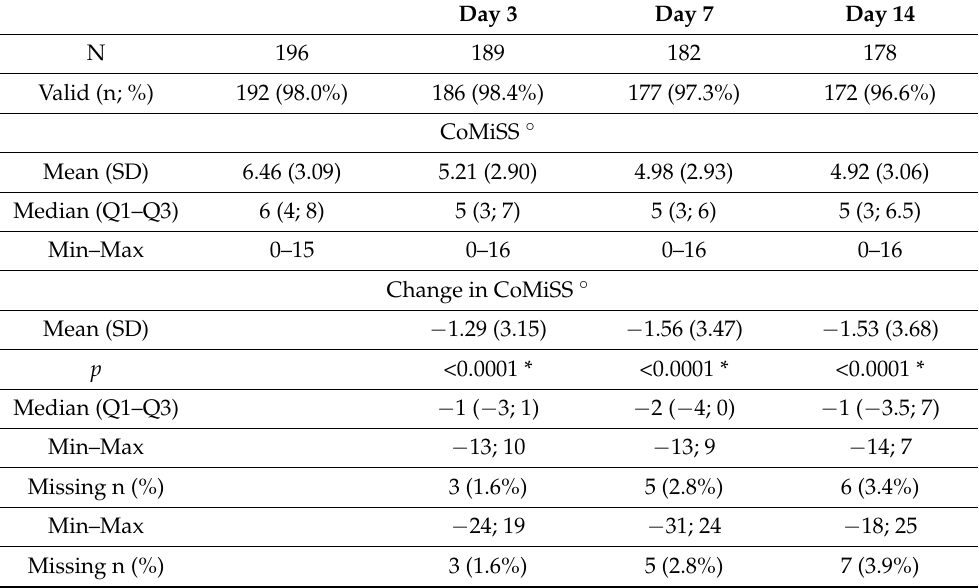
Table 4. The evolution of global CoMiSS.